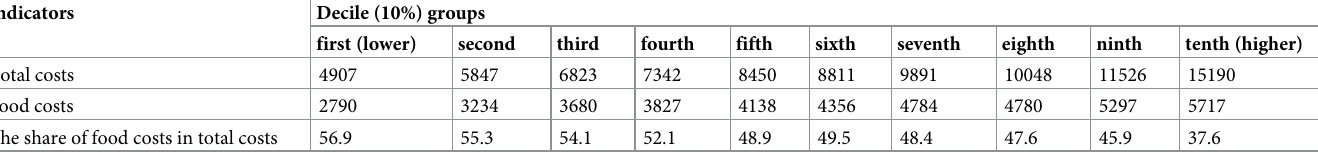
Table 4. Total expenditure of households by decile (10%) groups depending on size of per capita equivalent total income, 2020 (on average per month per house- hold, UAH). Indicators